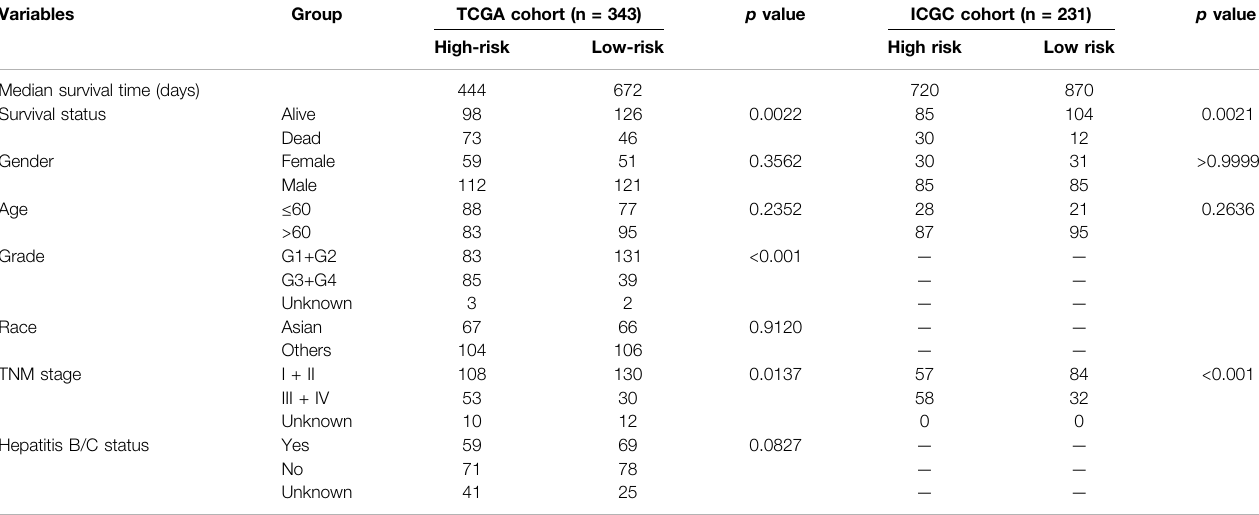
TABLE 1 | Baseline characteristics of the patients in different risk groups of the TCGA and ICGC cohort.